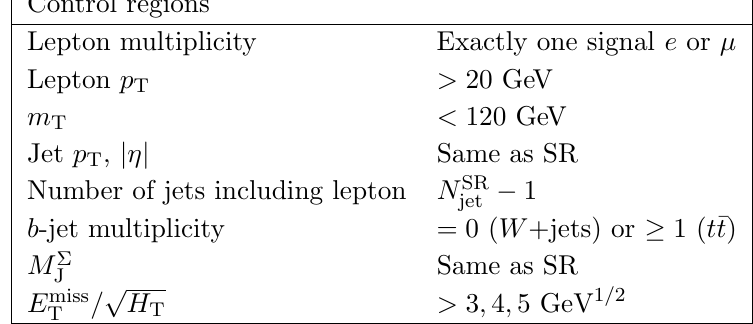
p = H T (through H T ) and also M (cid:6) . T J